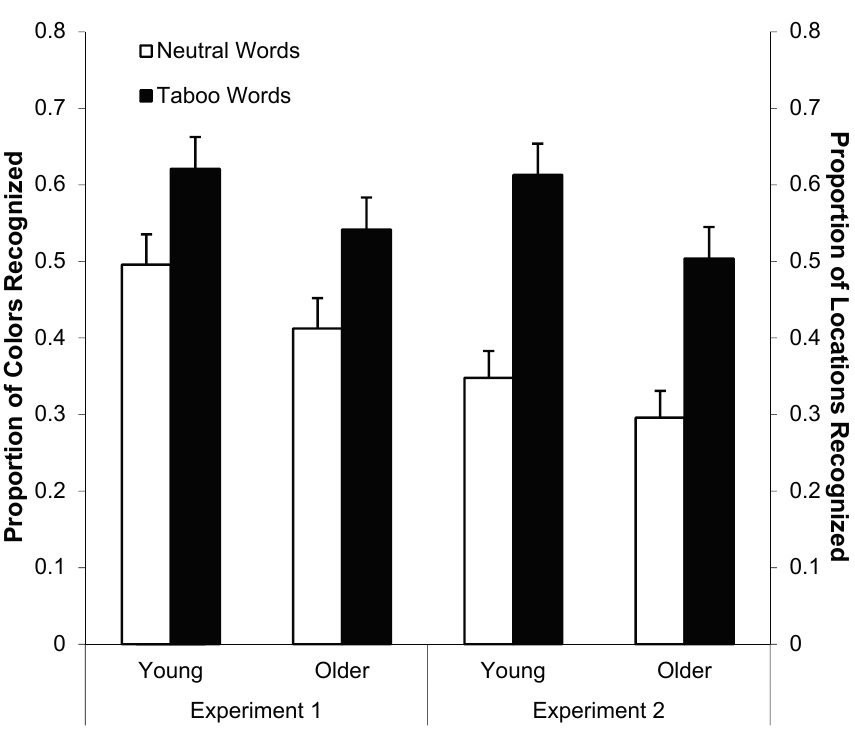
Figure 7. Mean proportion correct recognition memory (+ SE ) for consistent vs. inconsistent font colors (Experiment 1, left panel) and consistent vs. inconsistent locations (Experiment 2, right panel) as a function of age and word